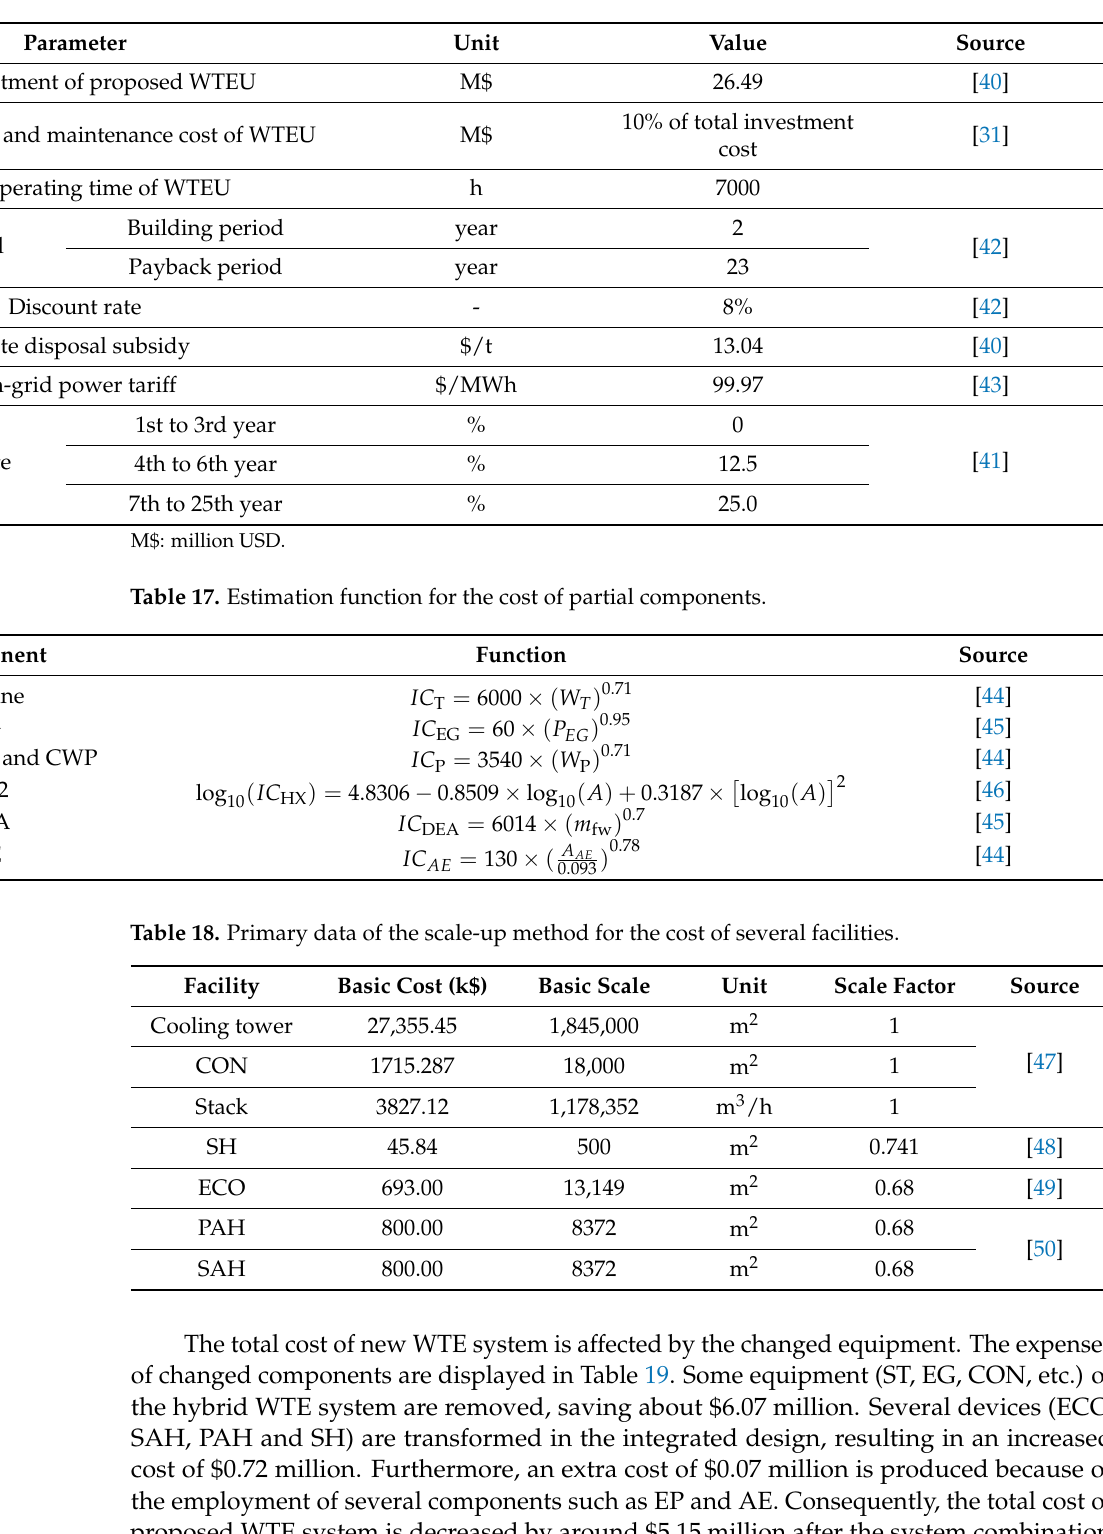
Table 16. Essential parameters of the economic analysis.